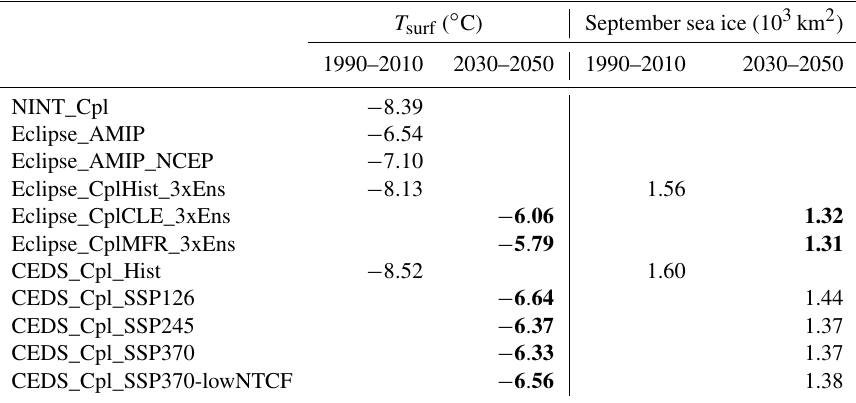
Table 8. Near-surface temperature ( T surf ) and September mean sea-ice extent in 1990–2010 and 2030–2050 periods as calculated by the GISS-E2.1. The bold numbers indicate the changes in the 2030–2050 mean compared to the 1990–2010 mean that are statistically significant on a 95% significance